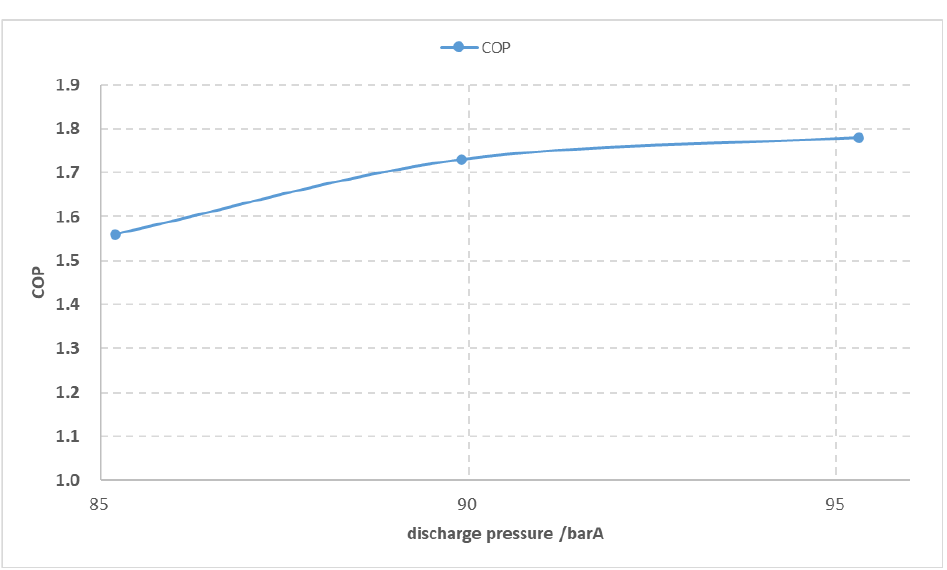
Figure 10. The capacity and air out temperature of the OHX air speed.